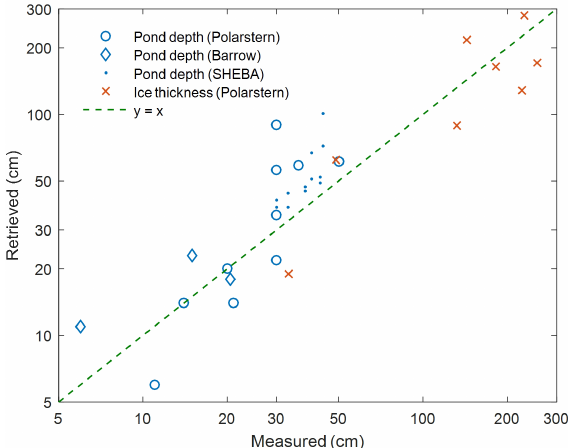
Figure 13. Ice thickness and pond depth, measured at different sta- tions and retrieved. For ice thickness R 2 = 0 . 56 ( N = 8) and for pond depth R 2 = 0 . 62 ( N =